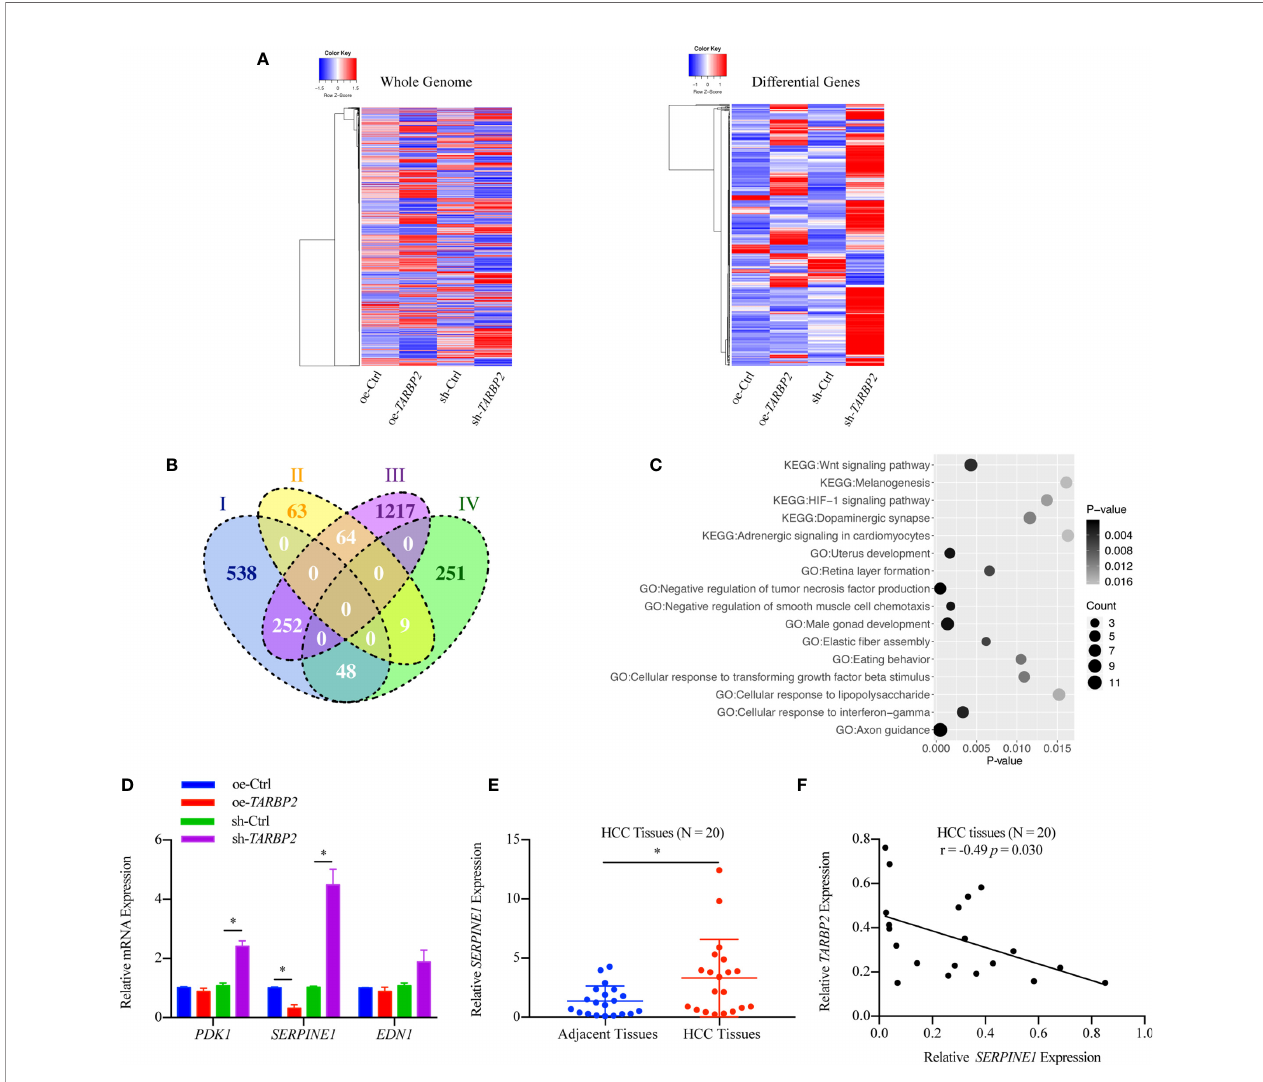
FIGURE 4 | Differential genes after overexpression and knockdown of TARBP2 in HepG2 cells. (A) Heatmaps represent the expression level of the whole genome (left) and showing the intersect of differentially expressed genes at 70% fold-change from two groups (right) respectively. (oe-Ctrl vs oe- TARBP2 , and sh-Ctrl vs sh- TARBP2 ). (B) A Venn Diagram of differentially expressed genes at the cut-off of 70% fold-change. Group-I, up-regulated genes from oe-Ctrl to oe- TARBP2 ; Group-II, down-regulated genes from oe-Ctrl to oe- TARBP2 ; Group-III, up-regulated genes from sh-Ctrl to sh- TARBP2 ; Group-IV, down-regulated genes from sh-Ctrl to sh- TARBP2 . (C) The KEGG pathways and GO biological processes enriched in the differentially expressed genes at 70% fold-change. (D) The mRNA expression levels of candidate genes from enriched pathway. (E) Relative expression levels of SERPINE1 in HCC tissues. (F) Correlation between the relative expression level of TARBP2 and SERPINE1 in HCC tissues. *p-value <